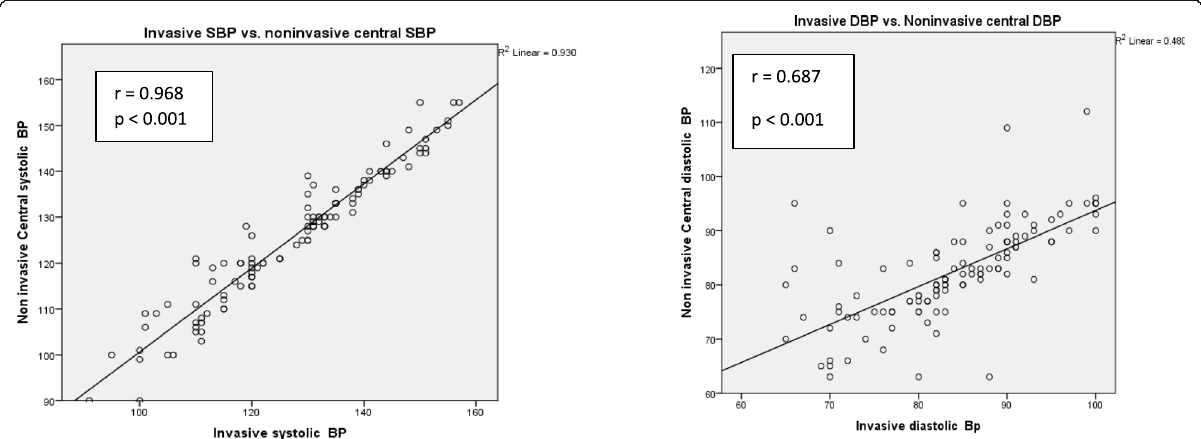
Fig. 2 Correlation between invasive (SBP/DBP) and noninvasive central (SBP/DBP) for the total patient population. BP, blood pressure; SBP, systolic blood pressure; DBP, diastolic blood pressure